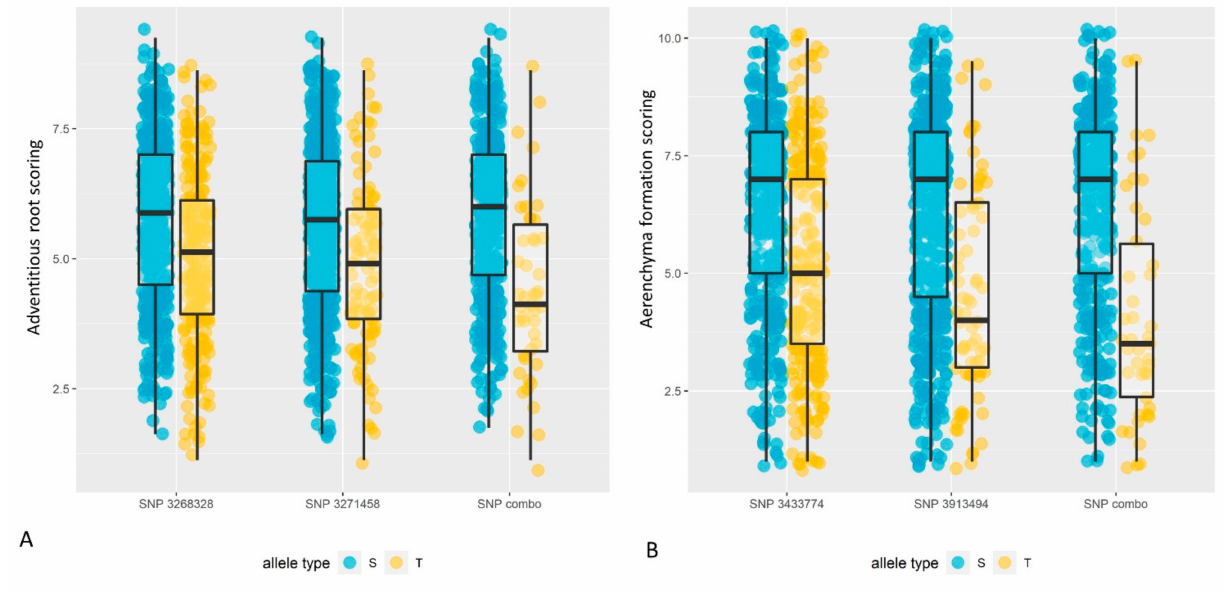
Figure 5. Allele effects of tolerant alleles (“T”) and susceptible alleles (“S”) from ( A ) AR development and ( B ) RCA formation. The data are for the top two SNPs (i.e., the most extreme p -values from the FarmCPU analysis) for AR development and RCA formation, respectively. The “SNP combo” data is from varieties, which have either both respective tolerant alleles, or both respective susceptible alleles. For AR development: n = 694 for SNP 3268328, n = 694 for 3271458, and n = 467 for the SNP combo. For RCA formation: n = 691 for SNP3433774, n = 691 for SNP3913494, and n = 466 for the SNP combo. The data are slightly jittered (at random) to expose the distributions, and the overlaying boxplots identify the interquartile range and the